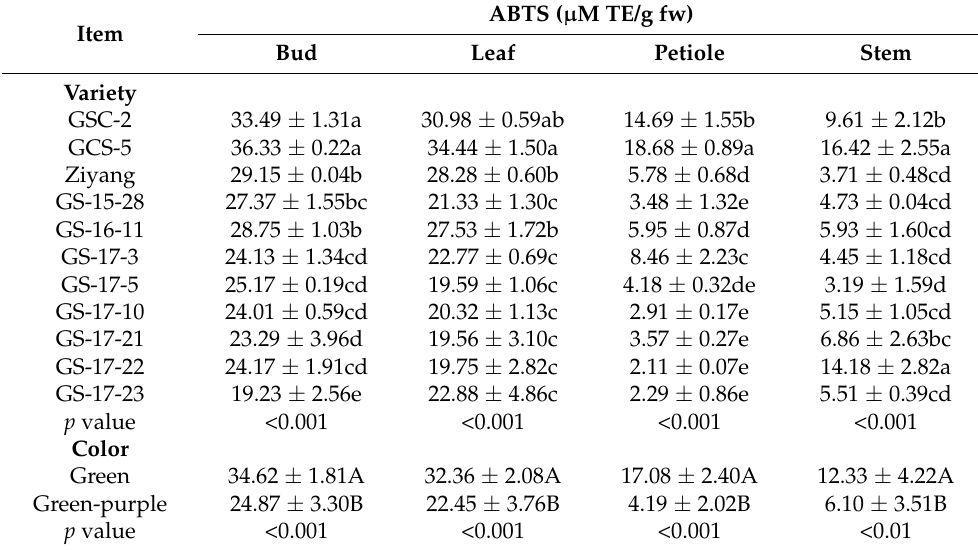
Table 3. The 2,2-azinobis-3-ethylbenzothiazoline-6-sulfonic acid diammonium salt (ABTS) radical scavenging activity of buds, leaves, petioles, and stems of 11 leafy sweet potato